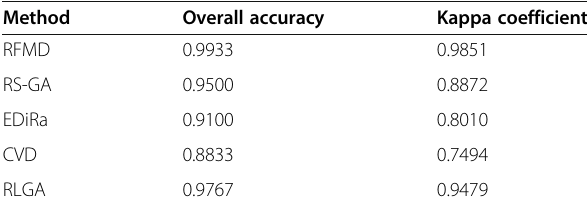
Table 14 Classification results in the first methylation dataset Method